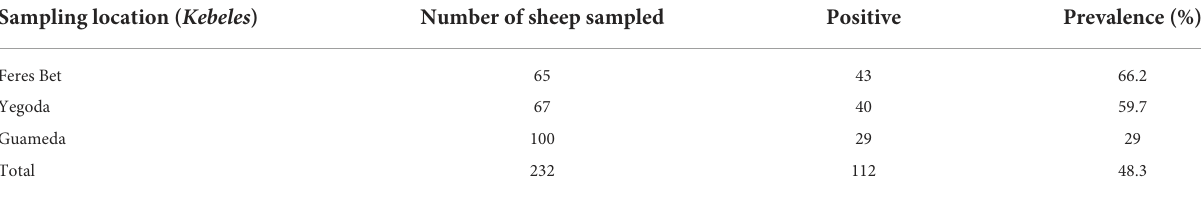
TABLE 1 Prevalence of sheep lice across sampling locations ( kebeles ) in Sayint district, South Wollo, Ethiopia. Sampling location ( Kebeles )